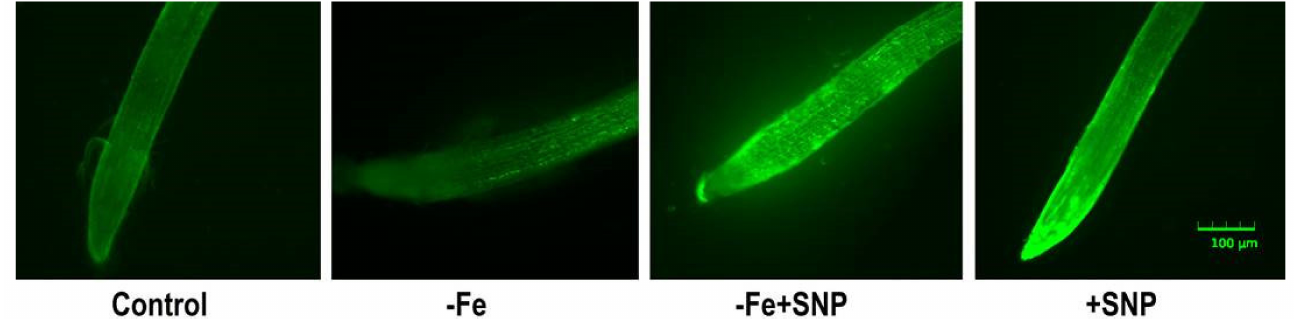
Figure 5. Endogenous accumulation of nitric oxide (NO) in alfalfa cultivated with different growth conditions: control (25 µ M FeNaEDTA); − Fe (0.1 µ M FeNaEDTA); − Fe (0.1 µ M FeNaEDTA) and sodium nitroprusside (SNP, 100 µ M) as nitric oxide (NO) donor; and SNP (100 µ M). The pictures of the stained roots were taken at 10 × magnification. Scale bar = 100 µ